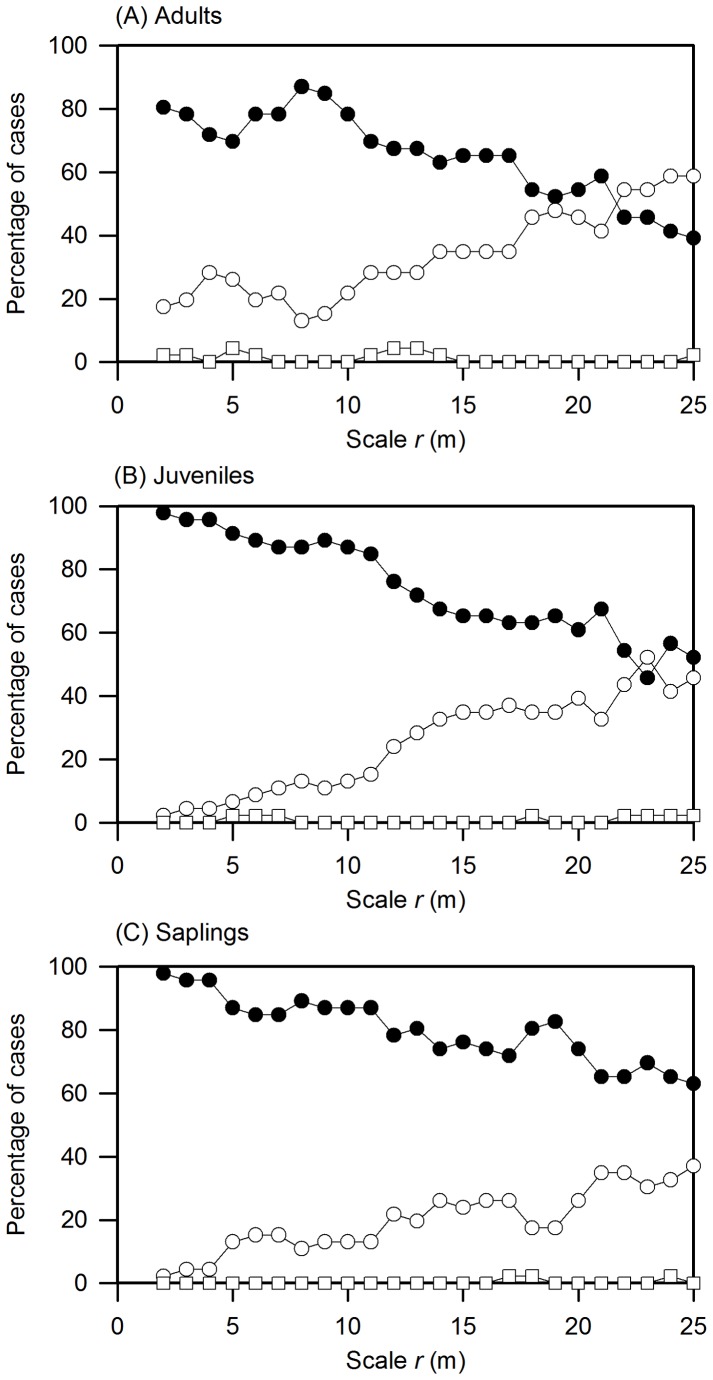
Analysis with the univariate K2-function.Percentage cases in which conspecific adult (A), juvenile (B), and sapling (C) patterns showed significant aggregation (black circles), regularity (squares), and randomness (white circles) at distance r. Significant departures from the CSR null model were estimated using the 5th-lowest and 5th-highest value of 199 Monte Carlo simulation envelopes for the 2–50 m distance interval. Values of K2(r) above, below or within the simulation envelopes indicate regularity, aggregation or randomness of the pattern, respectively. Note that the K2-function removes the confounding effects of large-scale habitat association.